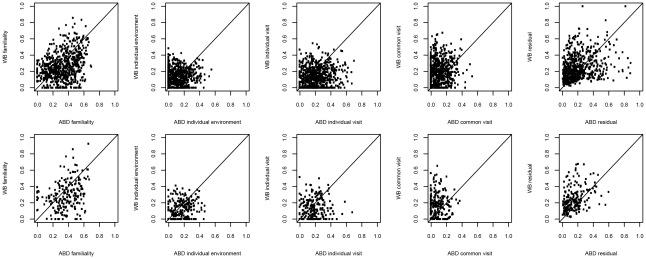
Sources of gene expression variation in different tissues.A) 626 probesets associated with MetS in MolOBB ABD B) 205 probesets associated with MetS in MolOBB GLU. Variances are decomposed in MolTWIN ABD and WB.